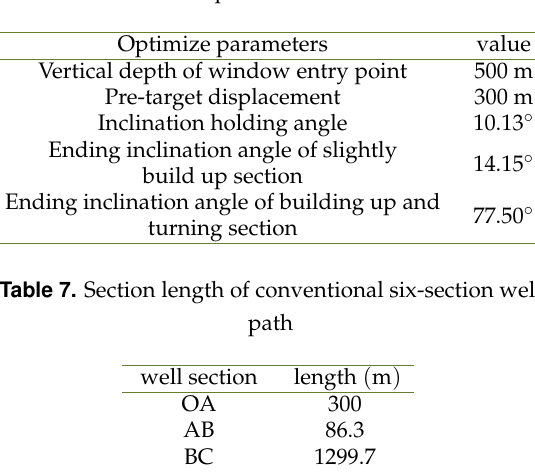
Table 6. The modified six section well path design